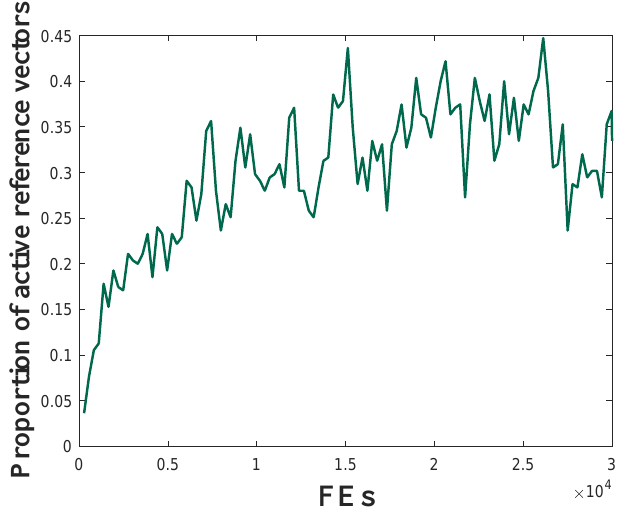
Figure 2. Variation of the proportion of active reference vectors during the optimization process of RVEAa on a ten-objective